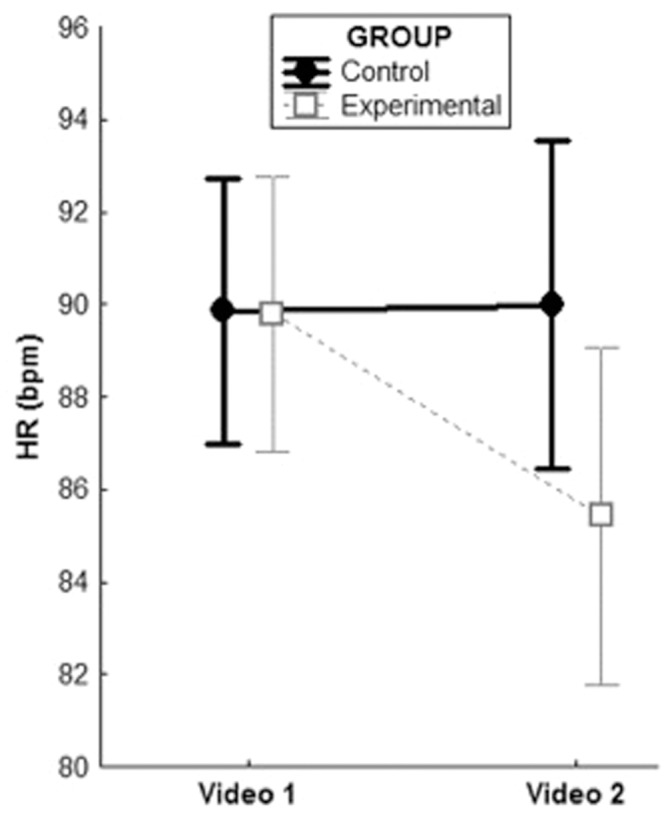
Group × Presentation interaction for HR during exposures to the videos, controlling for baseline HR.